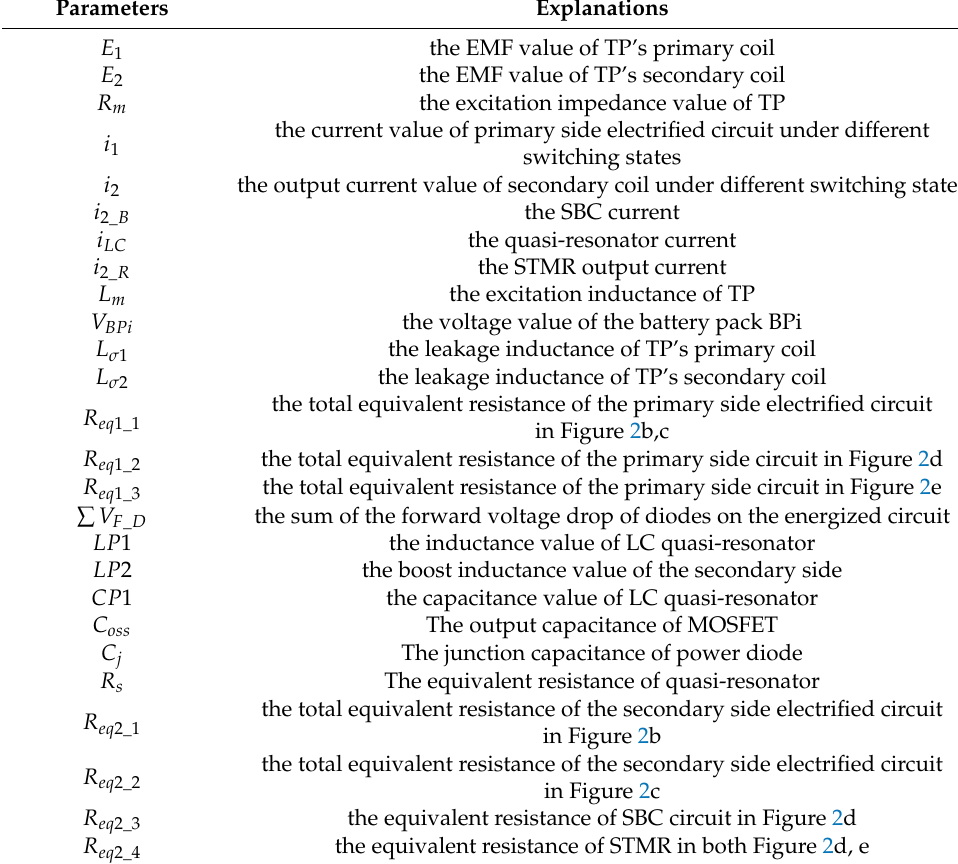
Table 2. Parameters and related explanations in the analysis of a pack